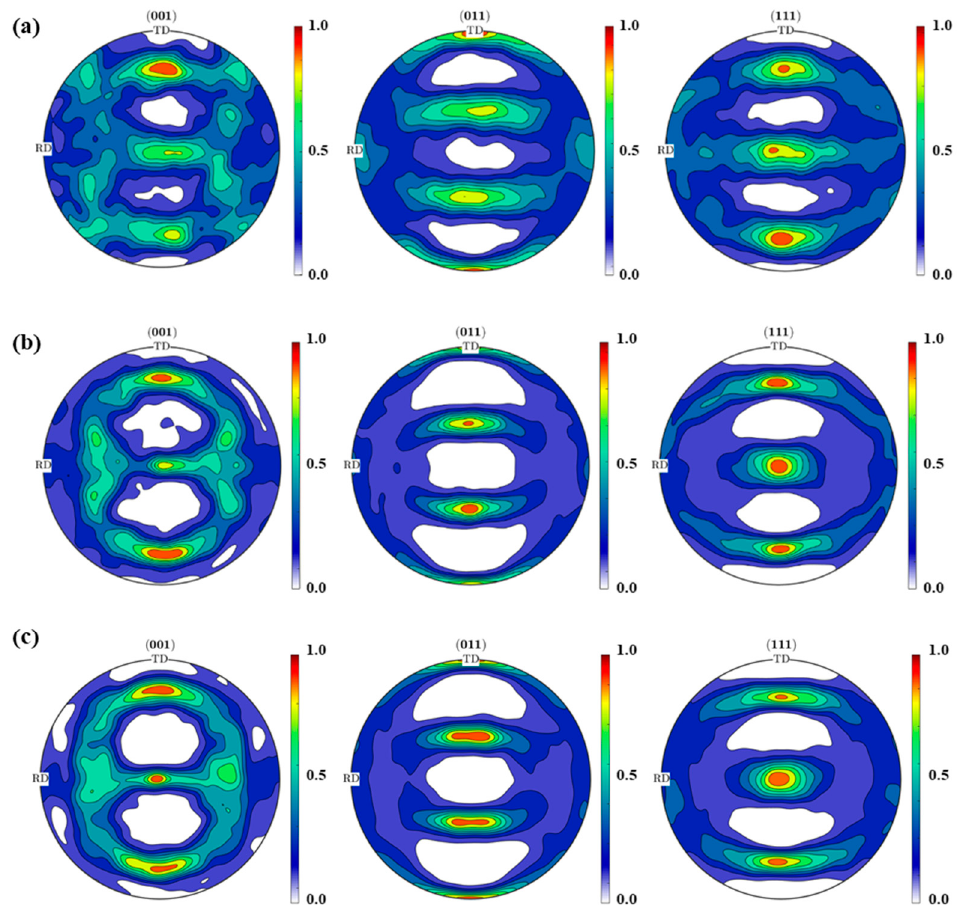
Figure 10. Cold rolling texture at the central layer of the center part of the S45C plate obtained by ( a ) EBSD measurement, ( b ) simulation with a CRSS ratio of 1:1:10, and ( c ) simulation with a CRSS ratio of 1:1:1.